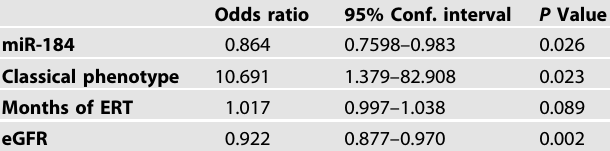
Table 3. Independent predictors of cardiac damage in 60 AFD patients on ERT (multivariable logistic